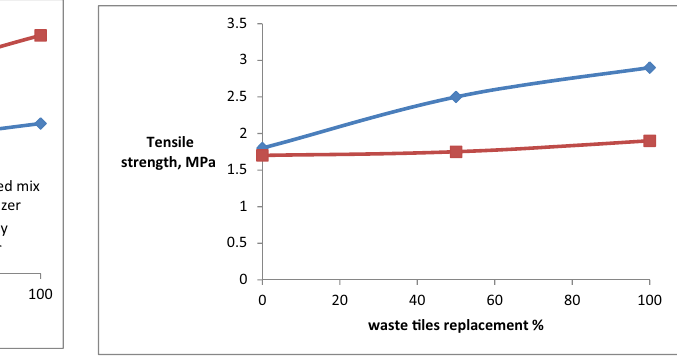
Figure 11: Compares on the relationship between tensile strength and replacement with and without modi fi cation by super - plasticizer.